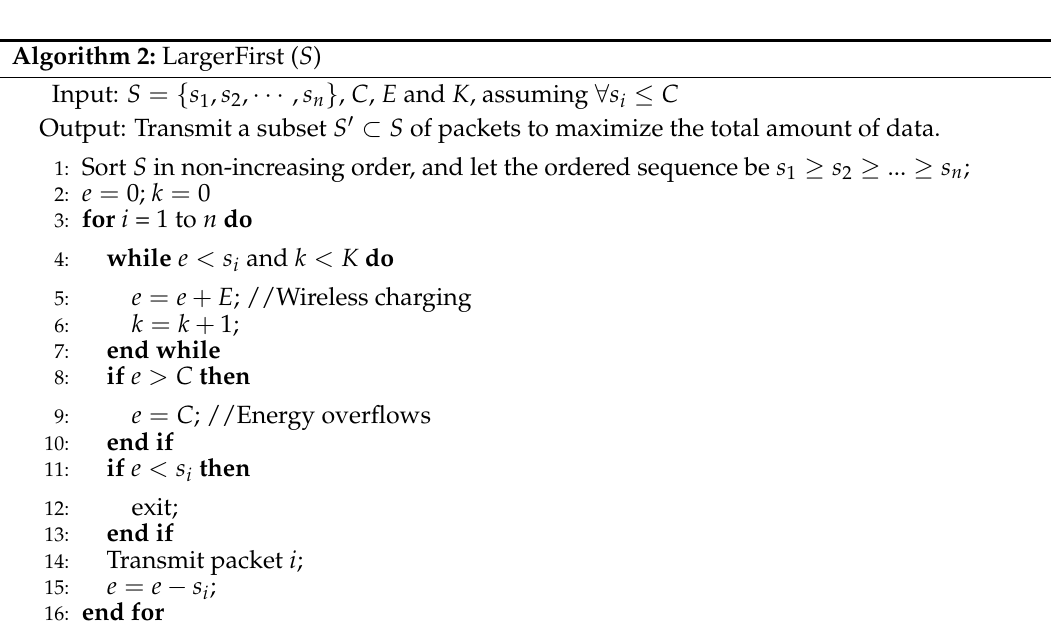
Algorithm 2: LargerFirst ( S